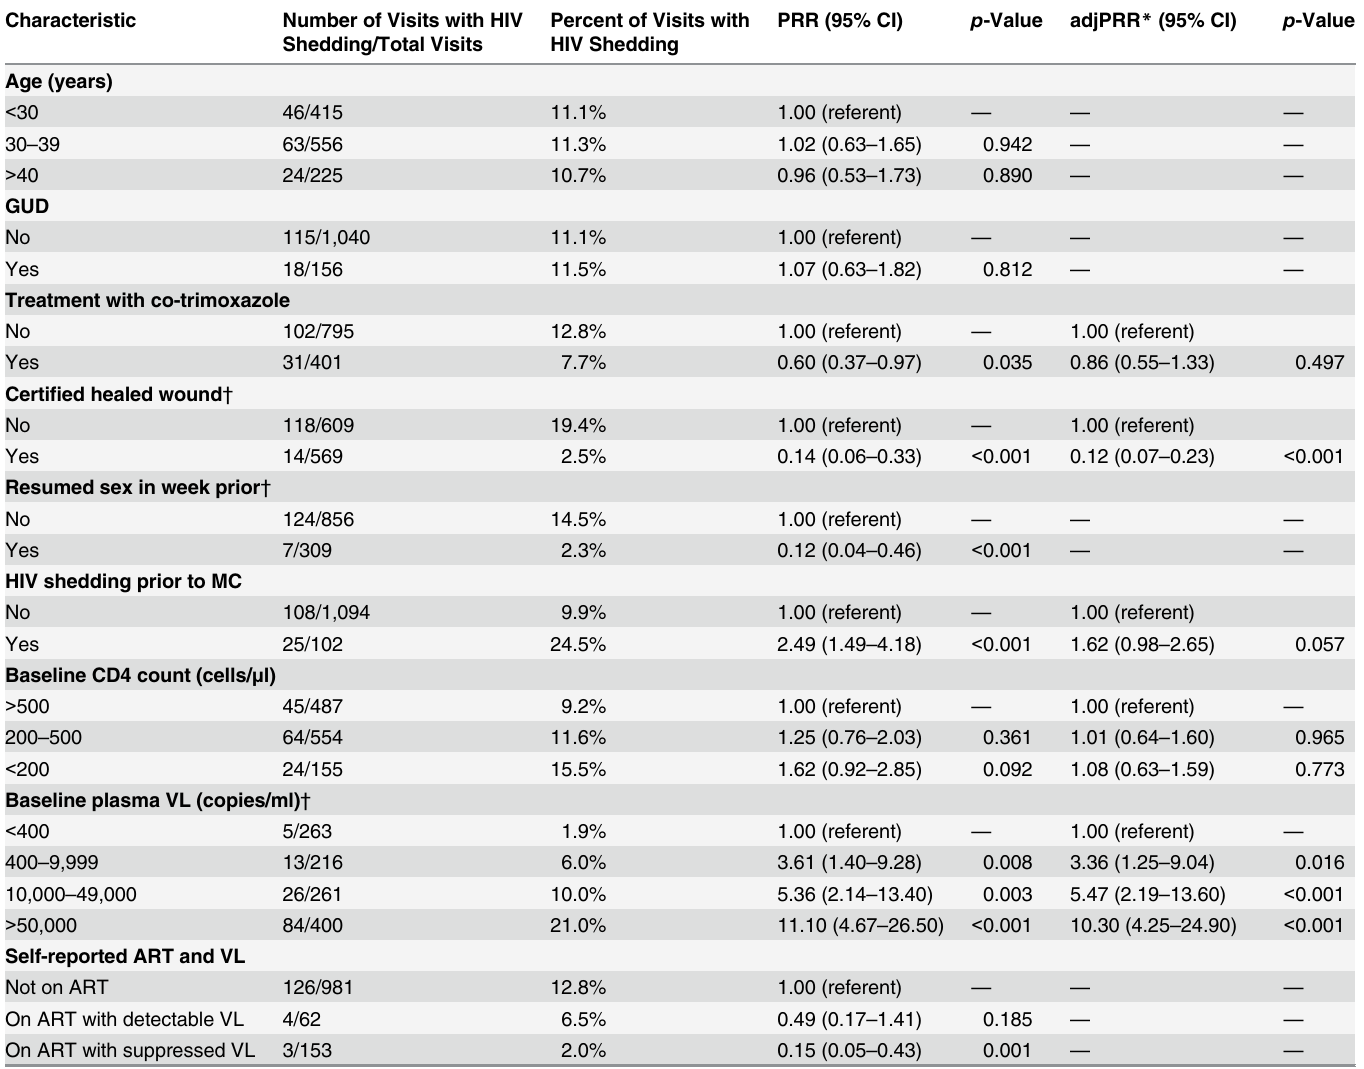
Table 2. Associations with the detection of penile HIV shedding.